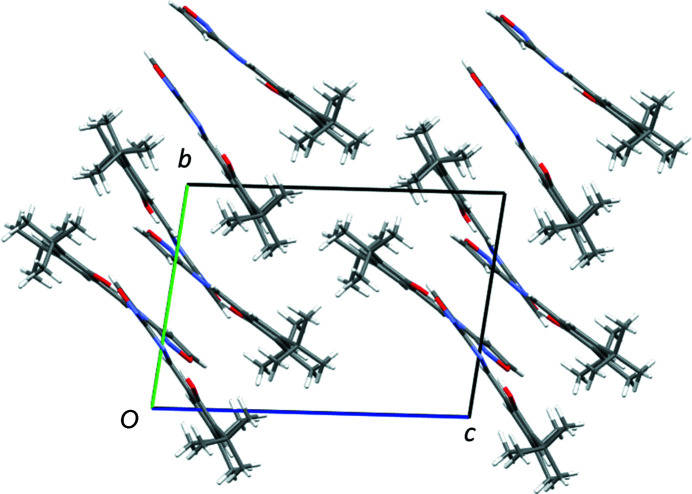
Illustration of the packing in 3, looking down the a axis.